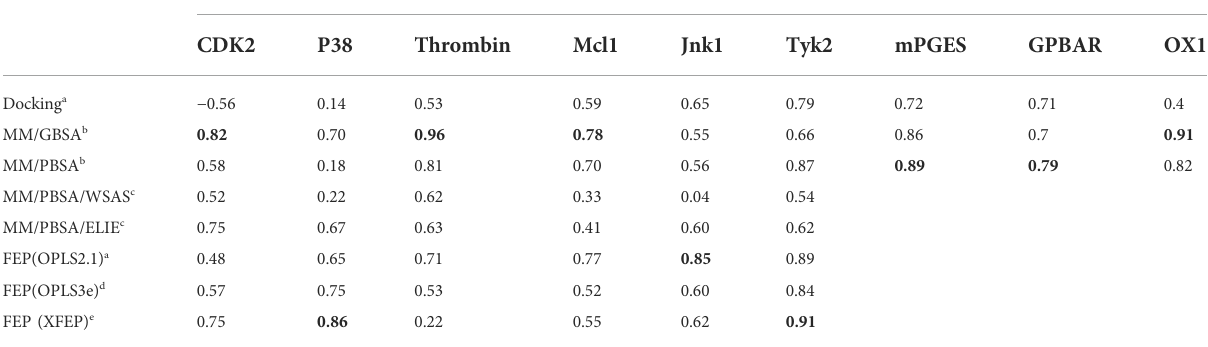
TABLE 3 The R-value of docking, MM/GBSA, MM/PBSA and FEP.